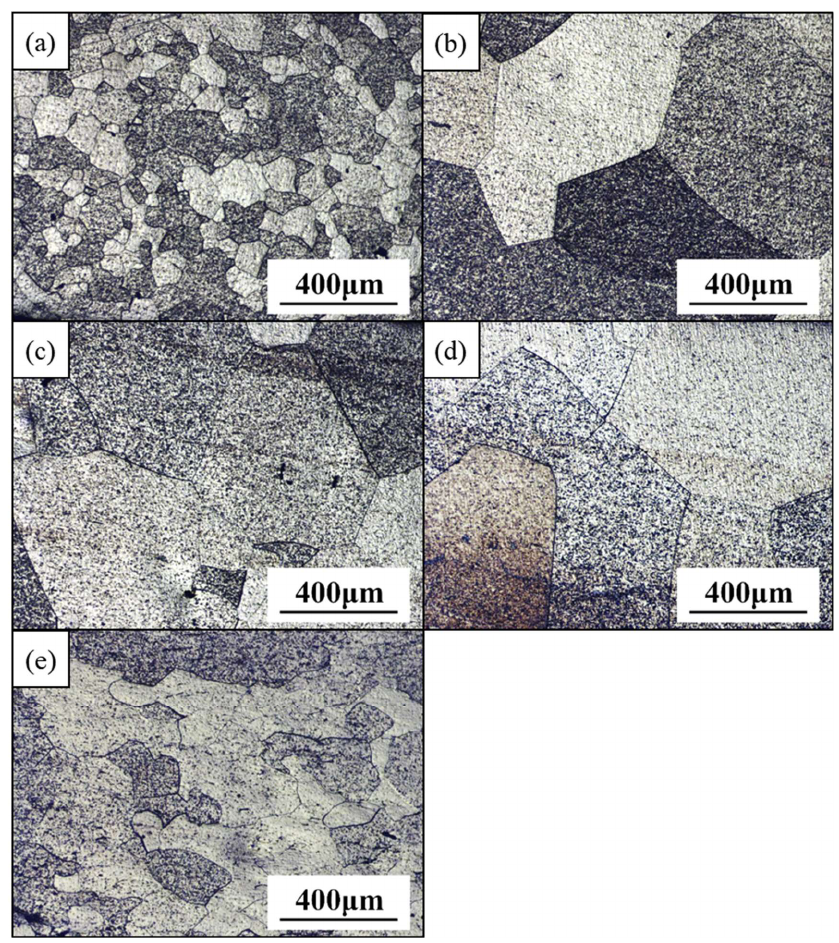
Figure 4. The appearance of the Ti 65 (AlCrNbV) 35-x Zr x (x = 3, 5, 7, 10) MEAs after homogenization heat treatment at 1000 °C for 2 h and hot rolling 50% at 1000 °C. ( a ) Zr3-homogenization; ( b ) Zr5- homogenization; ( c ) Zr7-homogenization; ( d ) Zr10-homogenization; and ( e ) Zr7-hot rolling.